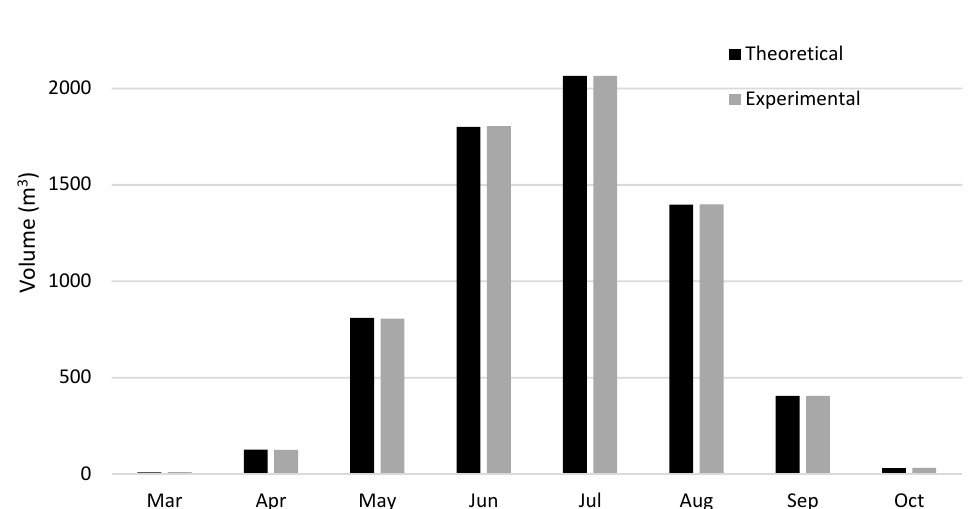
Figure 8. Theoretical irrigation volume requirements and experimental irrigation volume requirements for EPP 3.